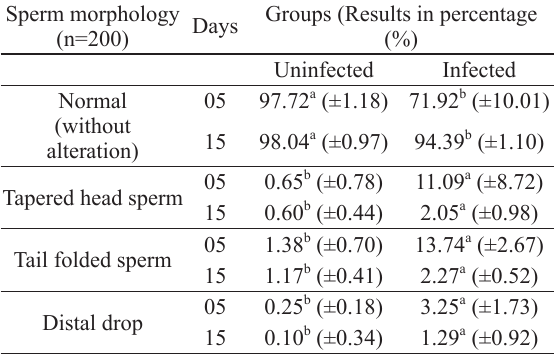
Morphological analysis of sperm in rats experimentally infected with Trypanosoma evansi . Results are shown as percentages (%), based on the evaluation of 200 sperm/animal.